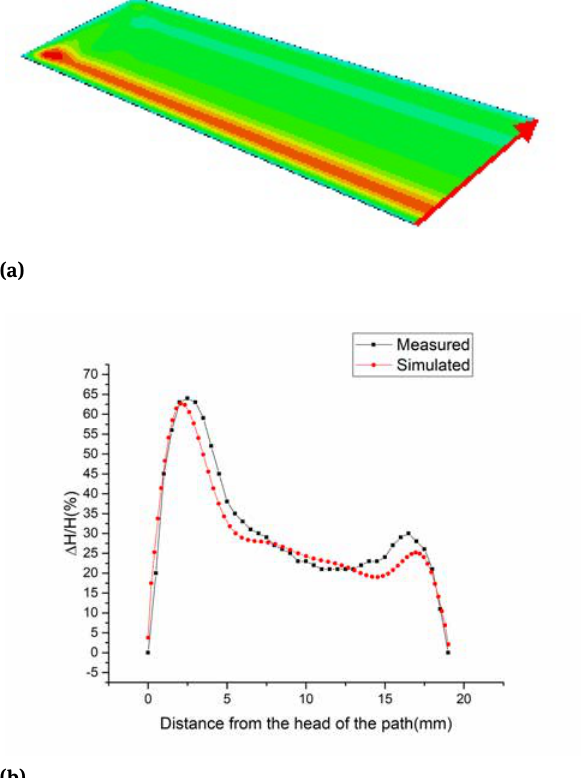
Figure 4: a) The output path; b) validation of the simulated fuel swelling